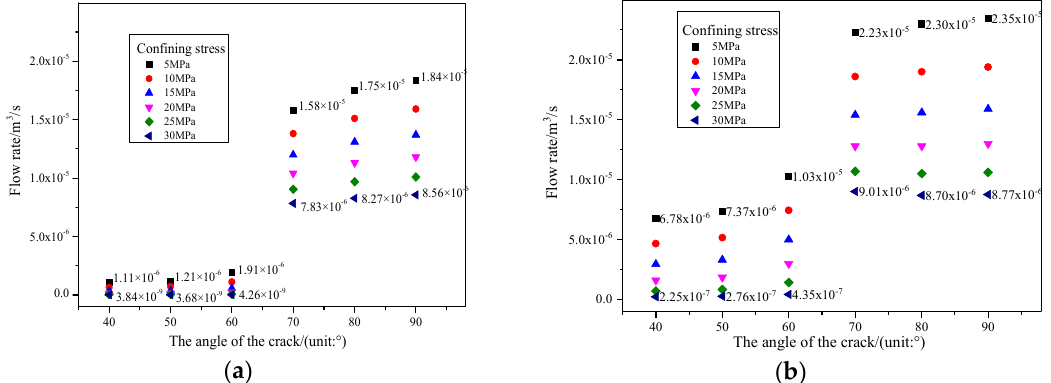
Figure 20. Flow rate change curves of different angles: ( a ) axial pressure 40 MPa and ( b ) axial pressure 10 MPa.